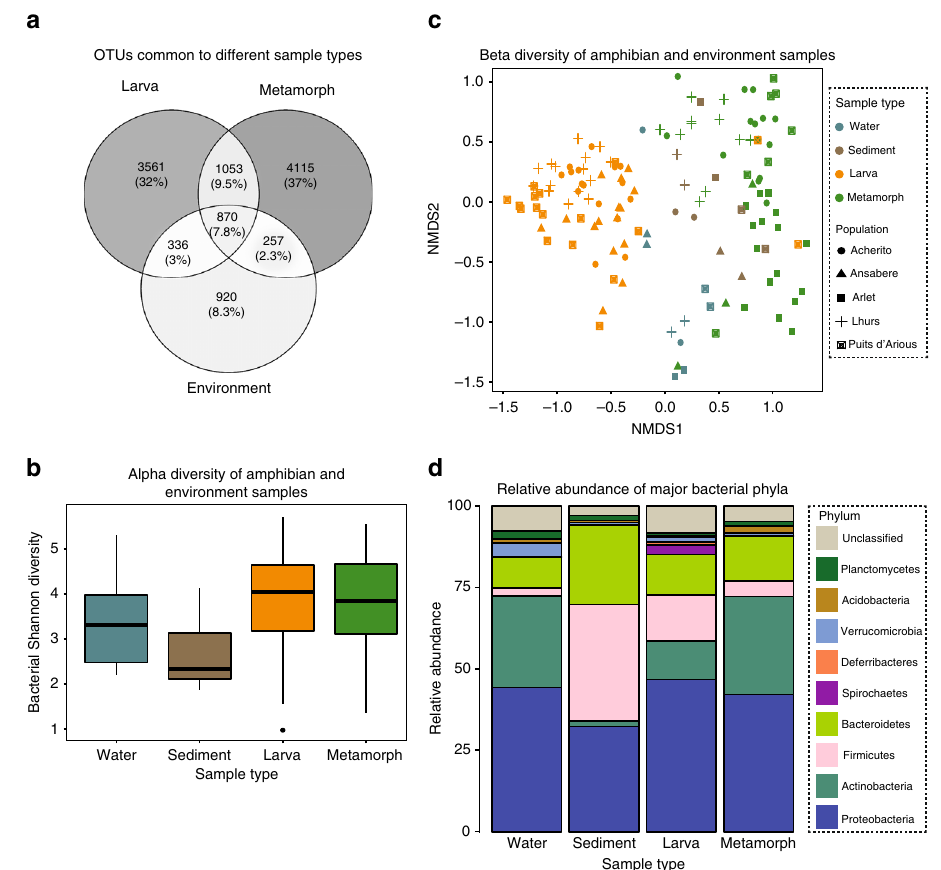
Fig. 1 Bacterial communities of Alytes obstetricans skin across life stages and in environmental samples. a OTUs common among life stages and environmental samples. b Shannon diversity by sample type (boxes represent 25 and 75 percentile, the horizontal line is the median, whiskers are maximum and minimum values). c NMDS plot of bacterial communities based on life stage, environmental samples and population. d Stacked bar chart of the ten most abundant phyla for lake water, sediment, larvae and metamorphs. Sample sizes were: n = 63 (larvae); n = 51 (metamorphs); n = 20 amphibian skin (Life Stage: PERMANOVA Pseudo-F (1,112) =